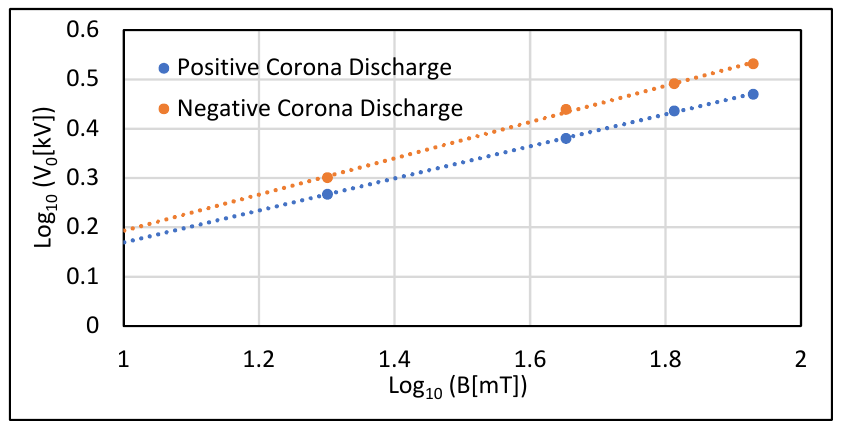
Figure 8. Corona inception versus the crossed magnetic field B for both discharge polarities on a log 10 scale.